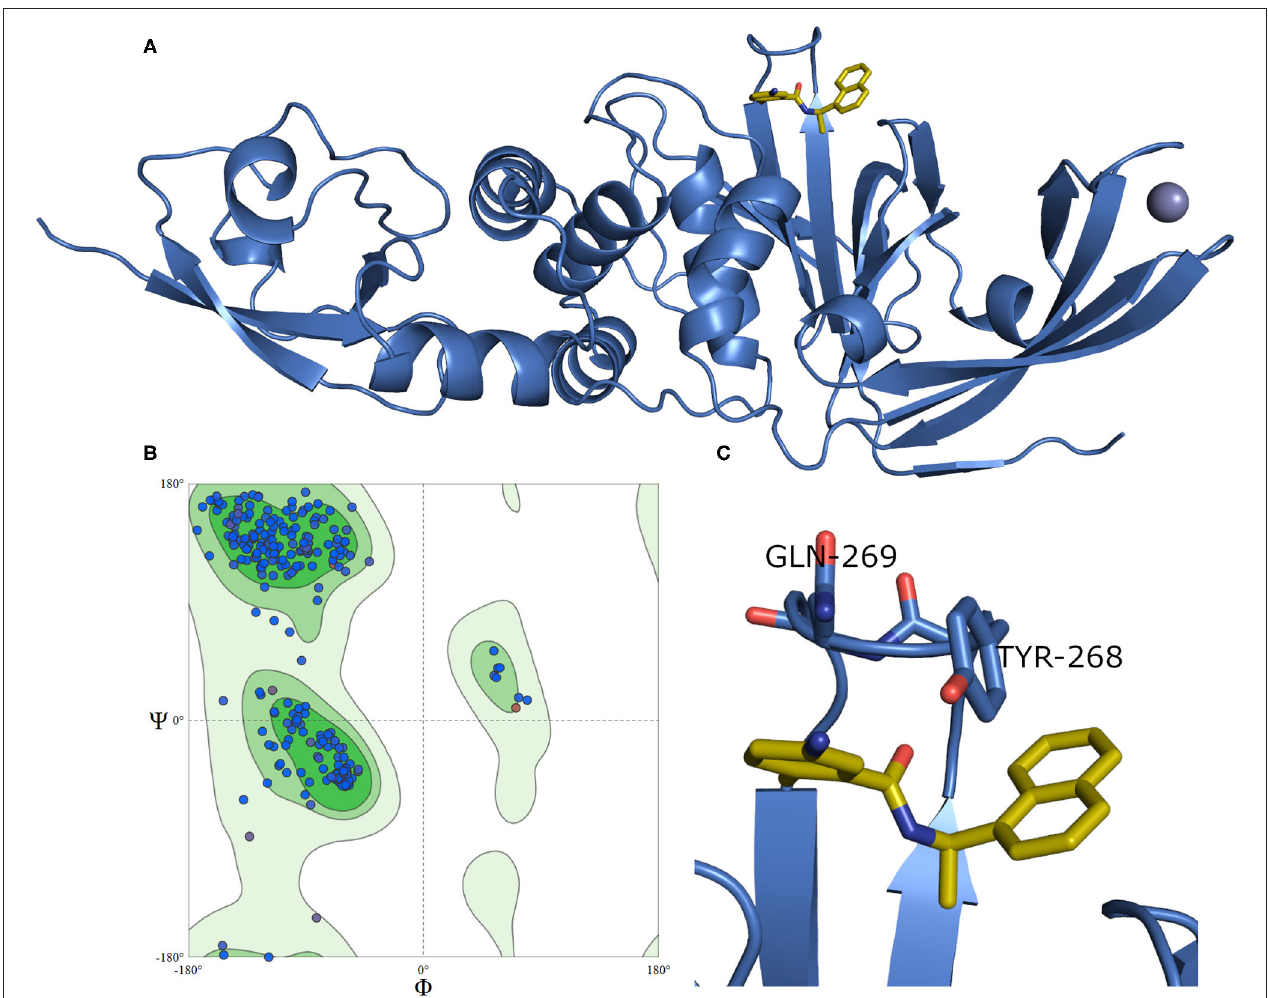
FIGURE 4 | (A) The newly emerged SARS-CoV-2 PLpro ligand-protein-complexed model built by SWISS-MODEL in the blue cartoon and its bound ligand in gold sticks. (B) Ramachandran plot for SARS-CoV-2 PLpro model. (C) The enlarged part of the binding site showing the conformations of the key Tyr268 and Gln269